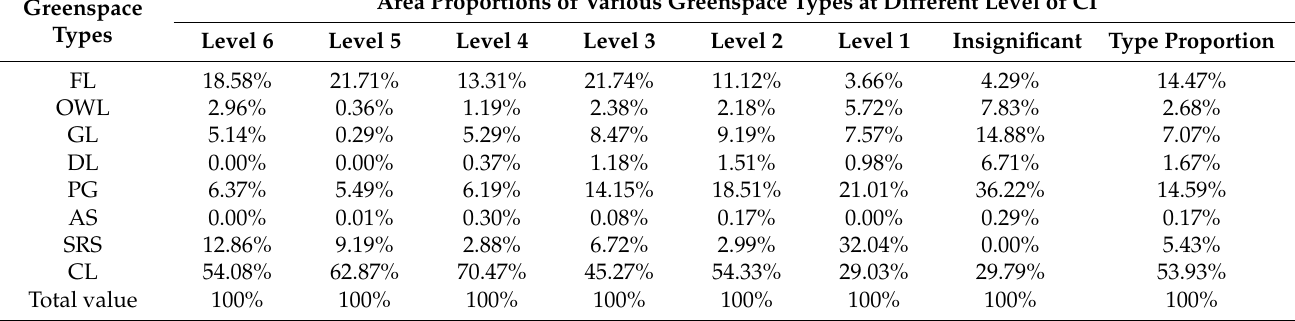
Table 5. Area proportions of various greenspace types at different CI levels in the riverfront area.